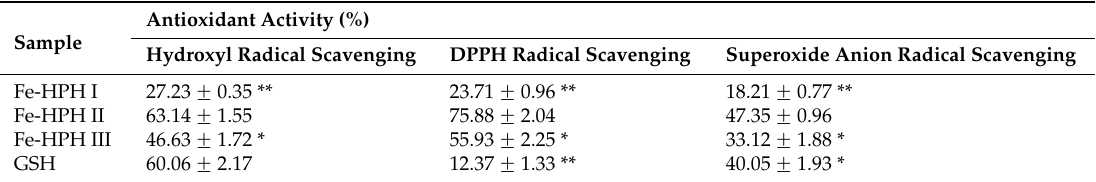
Table 2. In vitro antioxidant activity of three kinds of Fe-HPH chelates and glutathione (GSH).